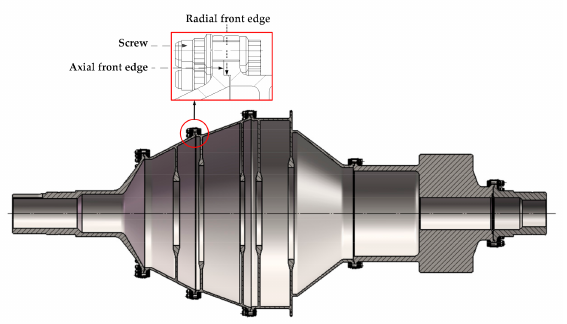
Figure 1. The section view of the drum-and-disk structure of a three-stage high pressure compressor (HPC) of an